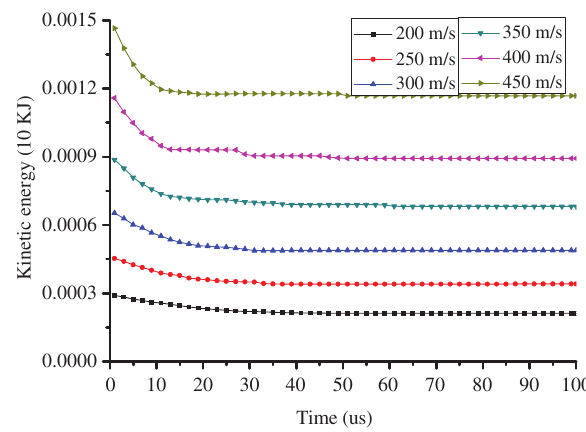
Figure 2: Bullet kinetic energy-time curves with different impact velocities.